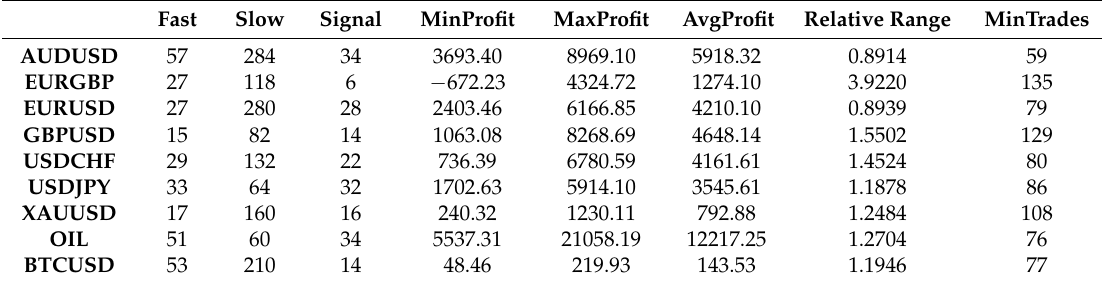
Table 2. Final parameters chosen for each asset and characteristics of their neighborhoods.